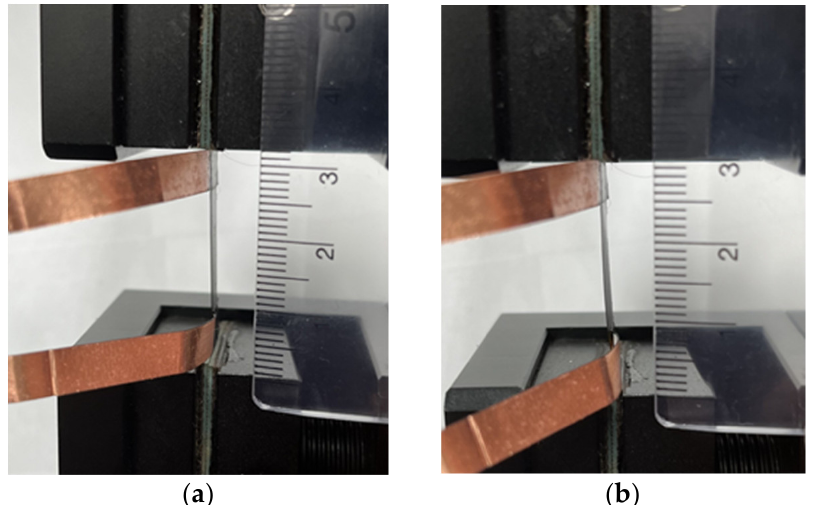
Figure 5. Nanomaterial film sensor subjected to a tensile test: ( a ) stretching 2 mm and ( b ) after stretch. Table 1. Tensile properties of the PI substrate.